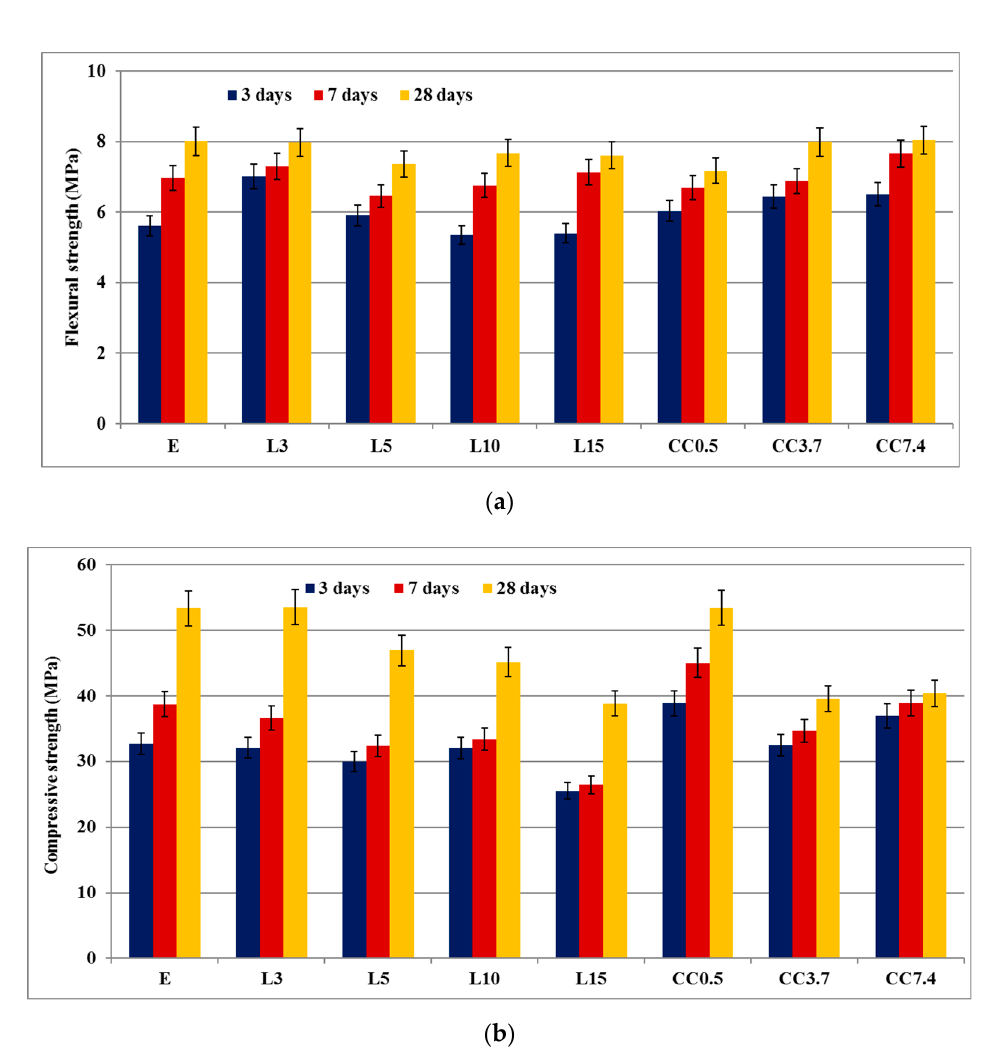
Figure 7. Mechanical strengths of mortars versus hardening time: flexural strength ( a ) and compressive strength ( b ).